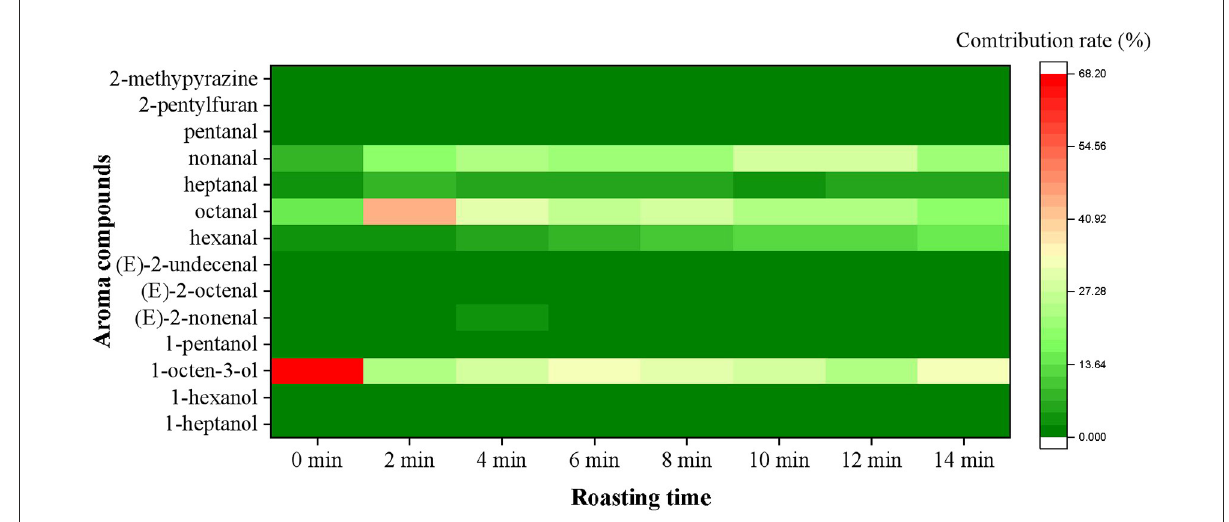
FIGURE2 Changes of contribution rates of aroma compounds (OAV > 1) in roasted Tan mutton during the roasting